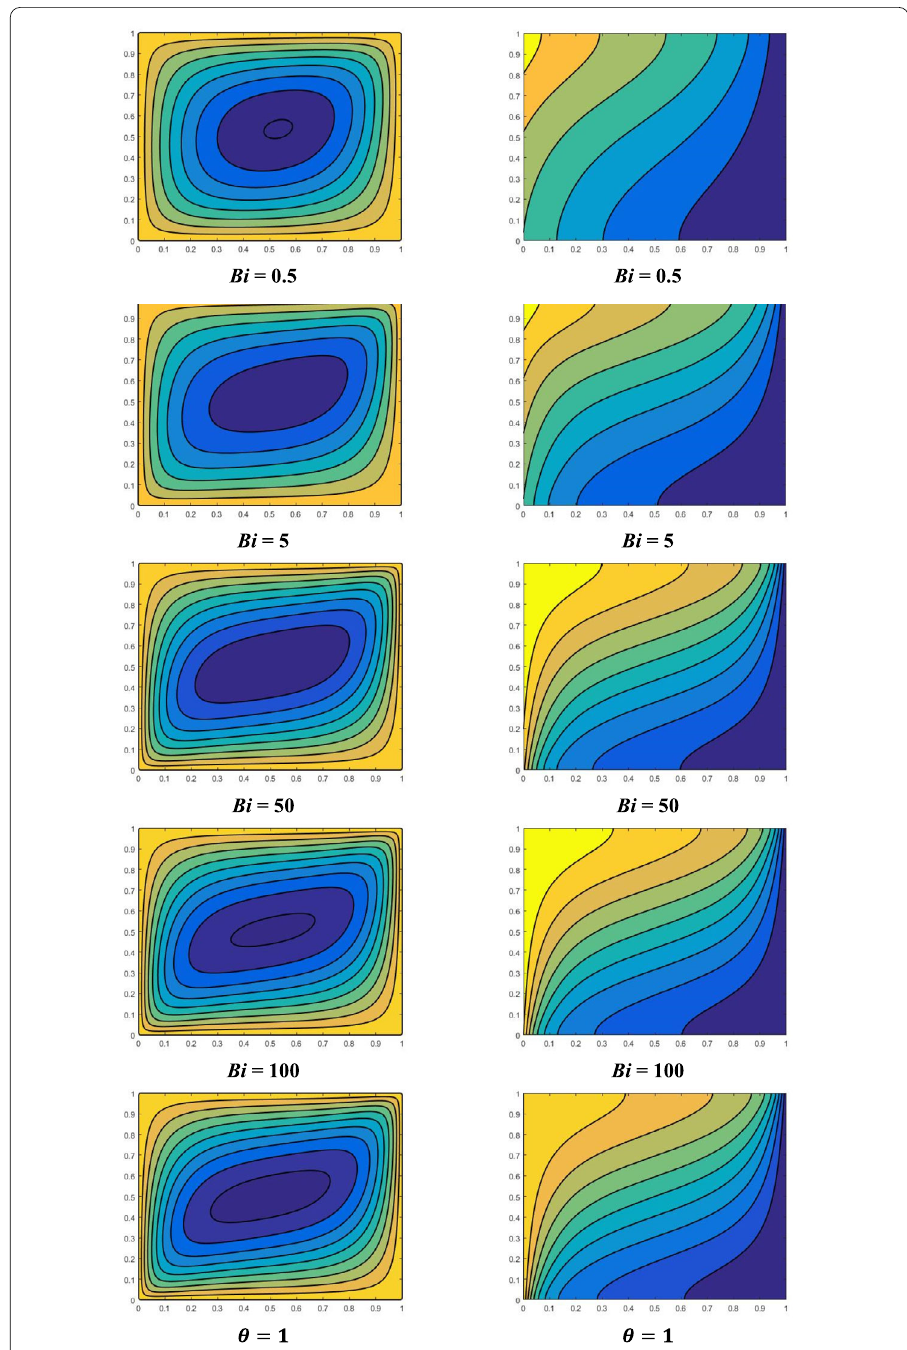
Figure 4 Streamlines (first column) and isotherms (second column), Ra = 100